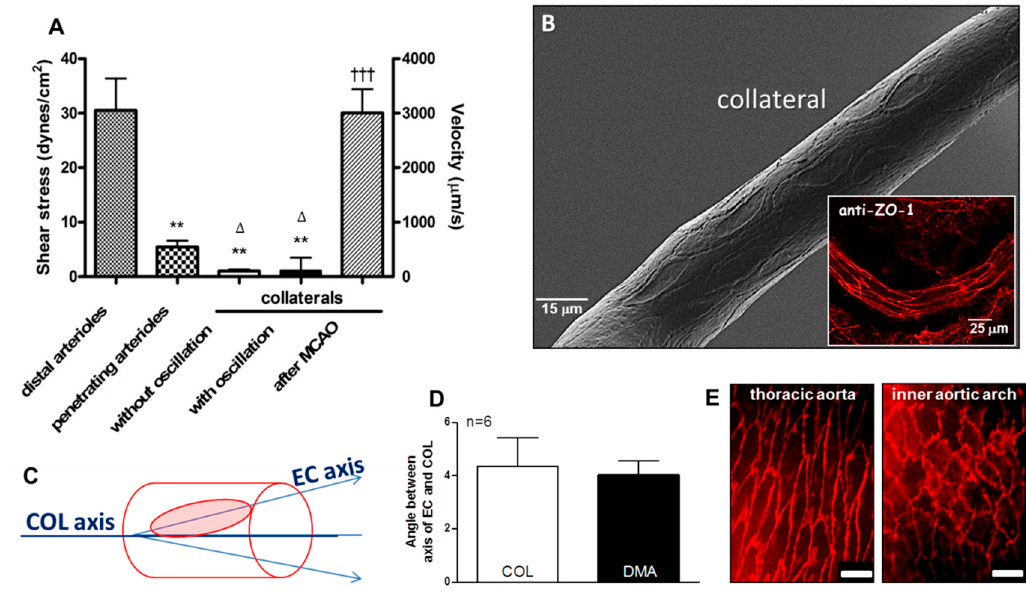
Figure 2. Collateral endothelial cells are aligned with the vessel axis despite having low and oscillatory flow / shear stress in the absence of arterial obstruction. ( A ) Data were obtained in anesthetized mice via cranial window and previously published in reference [6]; unlike distal-most arterioles (DMAs) with diameters comparable to collaterals (COLs) and penetrating arterioles, COLs examined over 30 s intervals have either no flow or slowly oscillating, low velocity, to-and-fro flow with ~zero net-direction. After ligation of the MCA trunk (MCAO), flow to its territory reaches that evident in DMAs within 10–30 s. ( B – E ) Collateral endothelial cells (ECs) have the same “anti-inflammatory” alignment (~4 degrees from horizontal) as ECs of DMAs and the descending thoracic aorta, despite having low / disturbed shear stress at baseline. This is in contrast to the “pro-inflammatory” non-alignment present in the inner curvature of the aortic arch. In this and subsequent figures, data are means ± SE for “ n ” number of mice. Data in D determined from SEM images, n = 6 mice. Panel E magnification bar is 25 µ m. Panel A 2-sided t-tests for shear stress followed by Bonferroni correction for ** p < 0.01 vs distal arterioles; ∆ p < 0.05 vs penetrating arterioles; 2-sided t-test for ttt p < 0.001 vs before MCAO. ZO-1, zona occludens-1 immunohistochemistry.